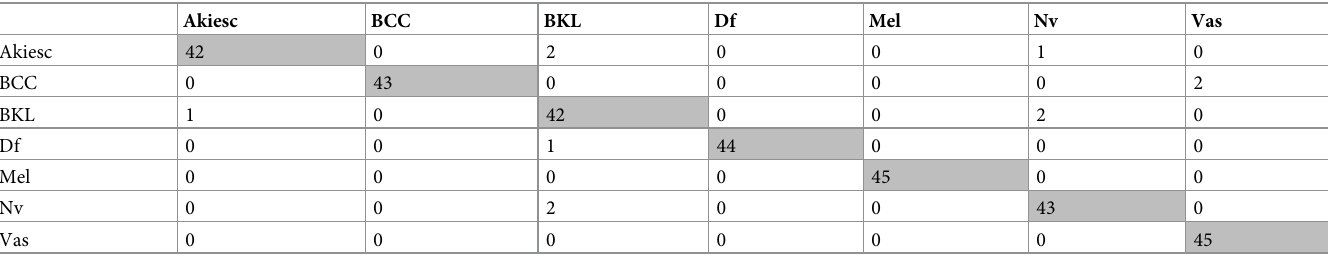
Table 1. Confusion matrix for 7 types of skin